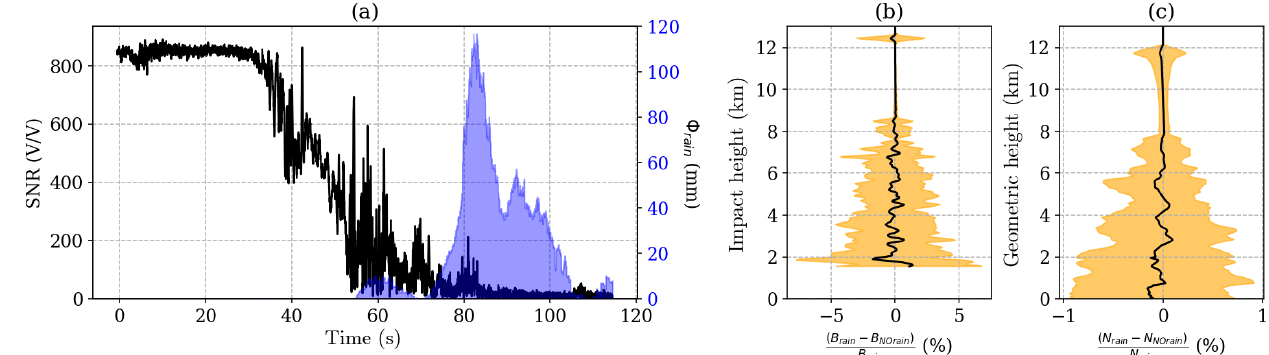
Figure 4. (a) Actual SNR (black) corresponding to the RO event C001.2008.345.00.43.G03 (UCAR ID), along with the simulated precipitation-induced phase delay (blue) as a function of time; (b, c) fractional bending angle and refractivity differences between the outputs from the retrieval using the rain-affected profiles and the rain-removed ones, as a function of the impact height (bending angle) and of the geometric height (refractivity). Black lines represent the mean of the 65 cases, while orange shading is the standard